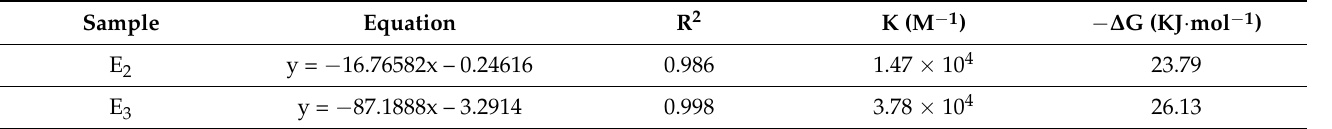
Figure 11. Plots of A 0 /( A – A 0 ) versus 1/[ DNA ] used to calculate the binding constants of algal polysaccharidic extracts with DNA: ( a ) E 2 and ( b ) E 3 . Table 6. Binding constants and binding free energy values for the interaction of algae polysaccharidic extracts with DNA from the UV data shown in Figure 6: E 2 and E 3 .